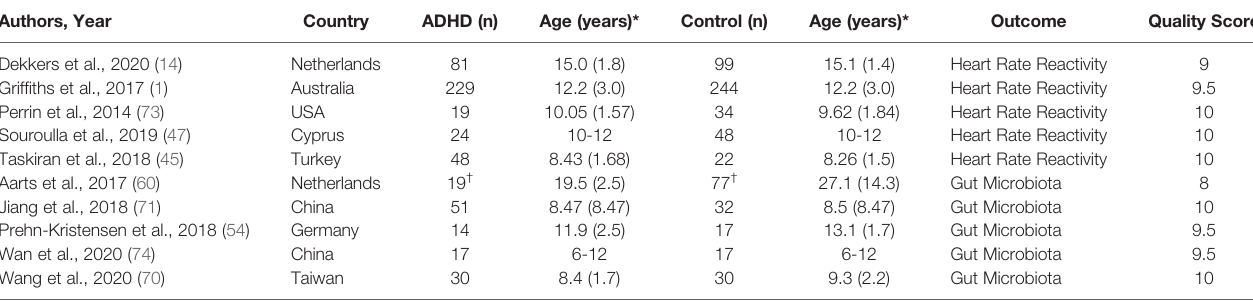
TABLE 1 | Summary Characteristics of Papers Included in the Meta-Analysis Separated by